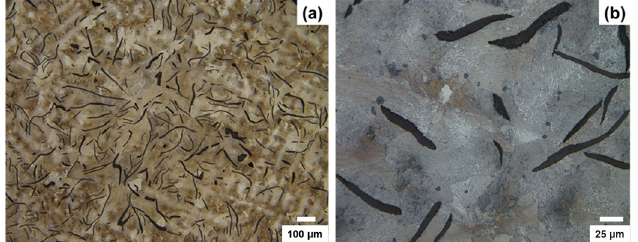
Figure 1. Optical microstructures of the cast iron material are shown in ( a ) depicting typical Type A graphite morphology with predominantly pearlitic matrix. High magnification microstructure shown in ( b ) confirmed fine pearlitic matrix.